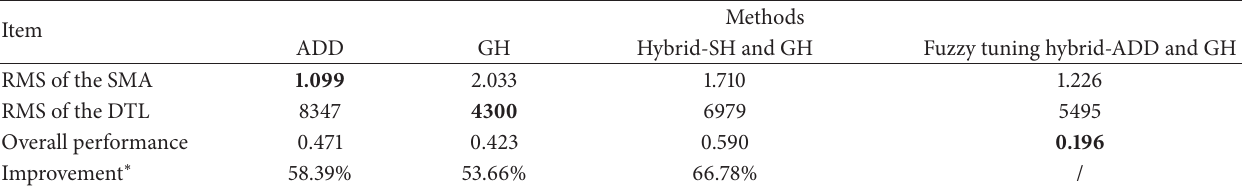
Table 3: Control performance with various control strategies.